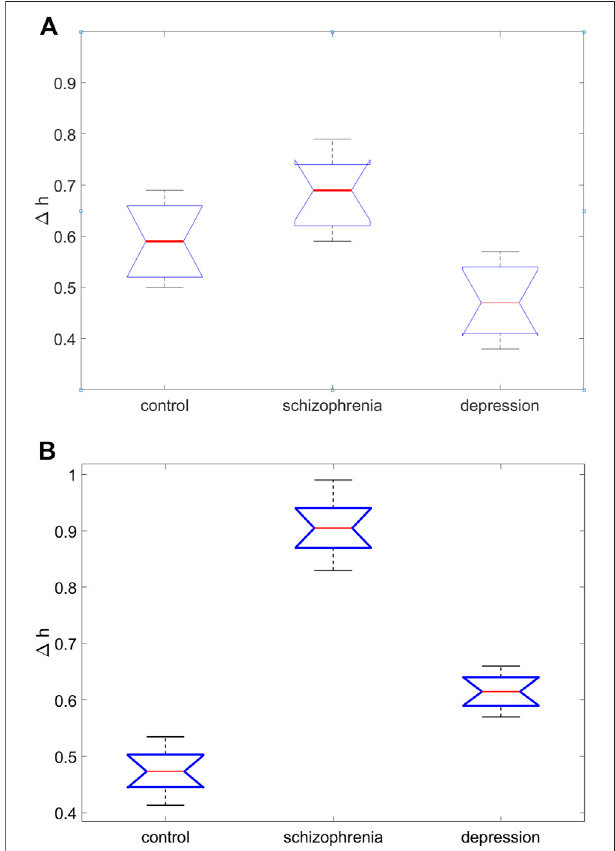
FIGURE 5 | Results of one-way analysis of variance for comparing the average values of the width of the singularity spectrum, Δ h , in three groups of subjects for the site C4 (A) and the site O2 (B)